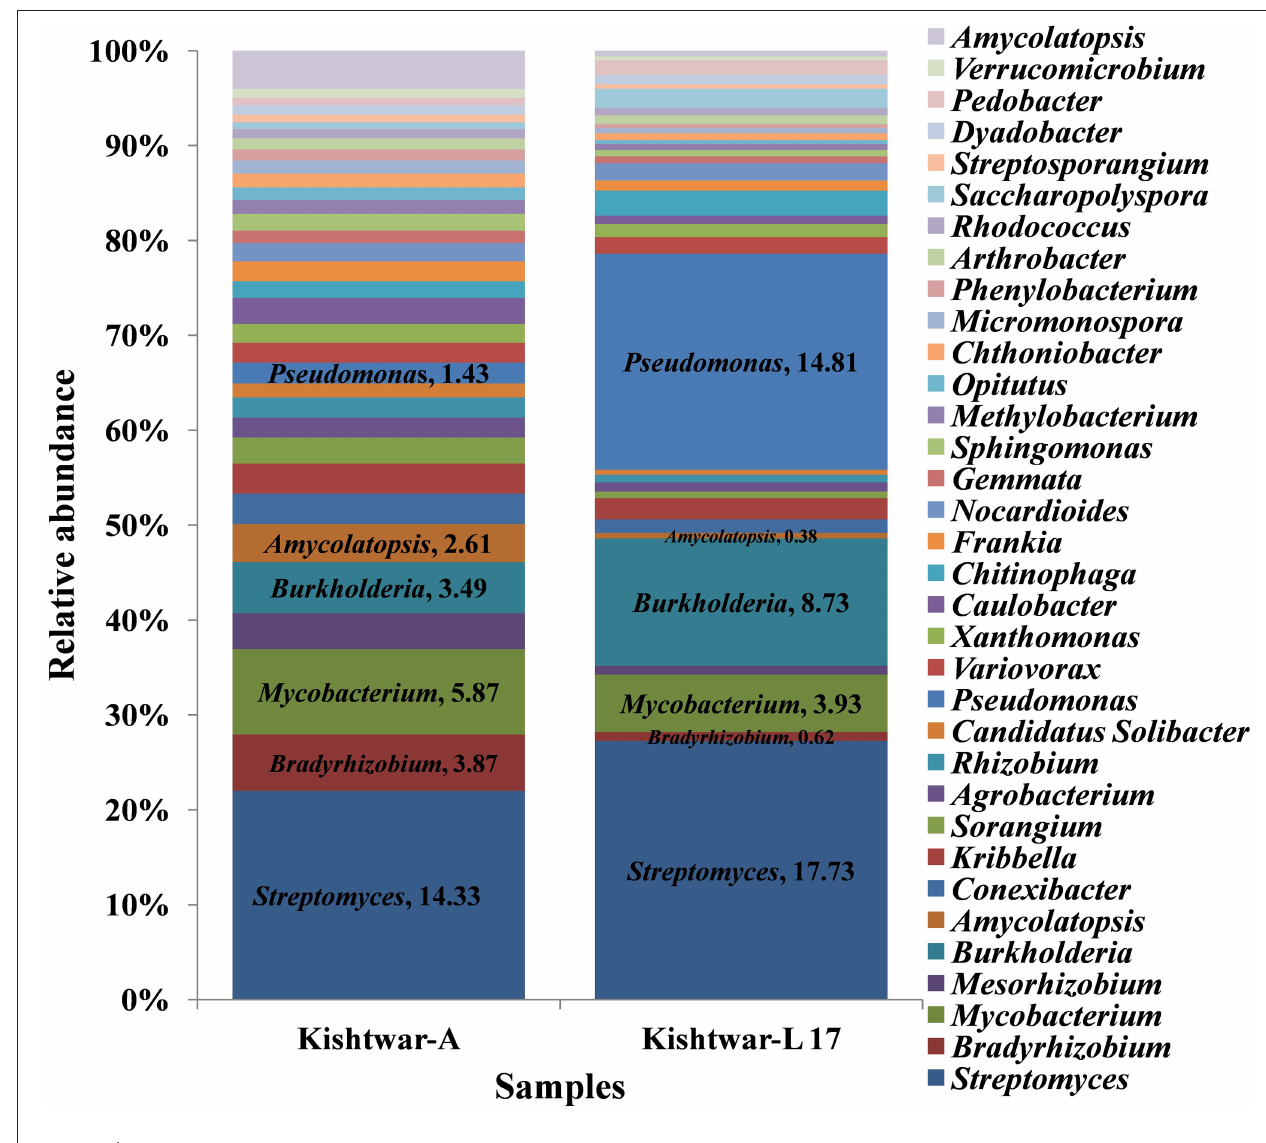
FIGURE 5 | Relative abundance of common 34 genera cataloged from Kishtwar-A and Kishtwar-L